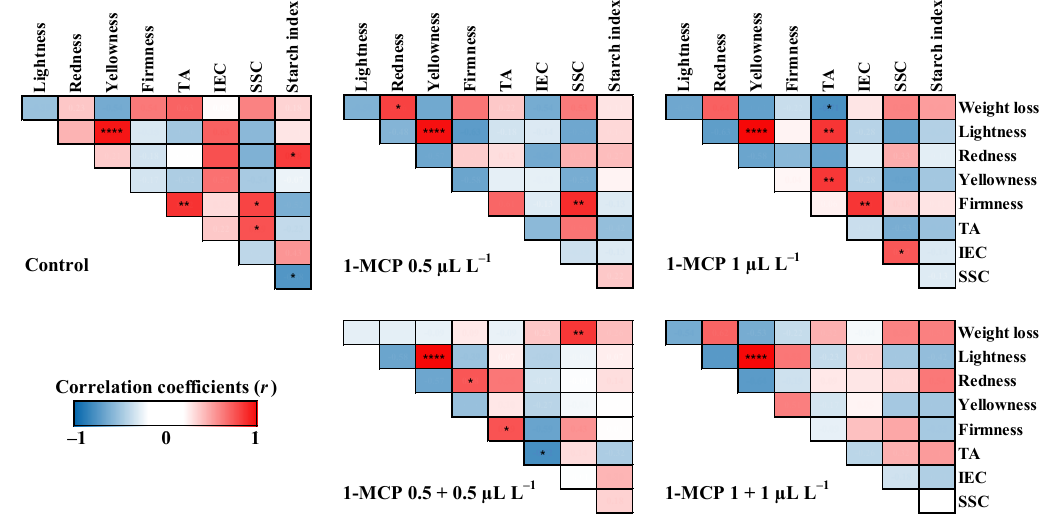
Figure 7. Pearson’s correlation coefficient ( r ) for fruit quality attributes in ‘Picnic’ apples treated with 1-MCP at different concentrations and number of applications during cold storage at 0 ± 1 °C with 90–95% relative humidity for up to six months. Red and blue colors represent positive and negative correlation between variables, respectively. Asterisks (*, **, ***, or ****) represent statistically significant correlation at p < 0.05, 0.01, 0.001, or 0.0001, respectively. TA: titratable acidity; IEC: internal ethylene content; SSC: soluble solids content; L *: lightness; a *: red/green value; b *: blue/yellow value.